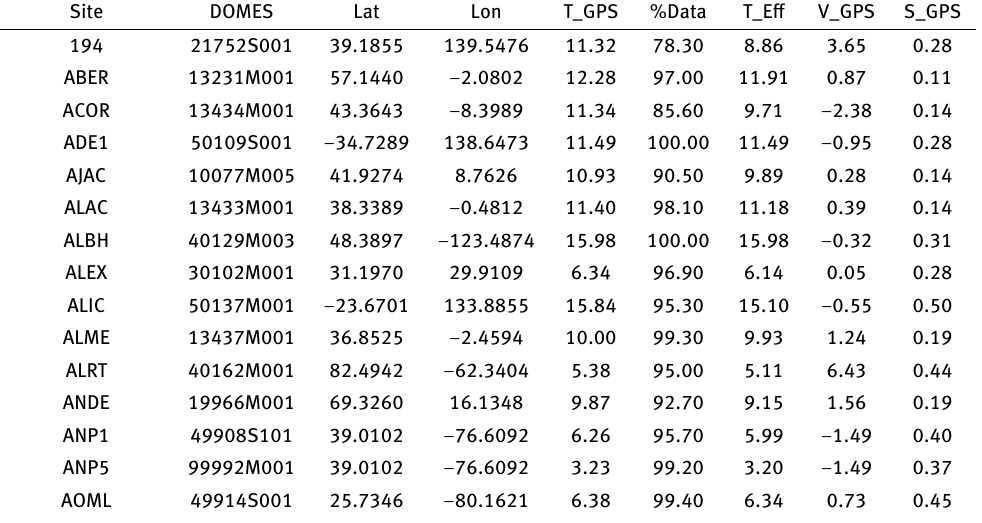
Table 2: Short record subsidence rate of inland GPS domes more or less far from some coastal tide gauge location in the SONEL data base. Data are shown as: "Site", GPS station acronym; "DOMES", GPS station number; "Lon", degrees, longitude of the GPS station; "Lat", de- grees, latitude of the GPS station; "T_GPS", years, Length of the GPS time series; "%Data", percentage of data in the time series; "T_Eff", = T_GPS * Data / 100, effective length of the GPS time series ; "V_GPS", mm/yr, GPS vertical velocity; "S_GPS", mm/yr, GPS vertical velocity uncertainty. Source